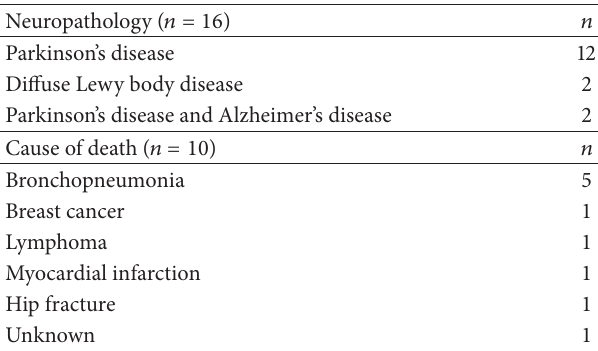
Table 3: Neuropathology and cause of death by autopsy. Neuropathology ( 𝑛 = 16